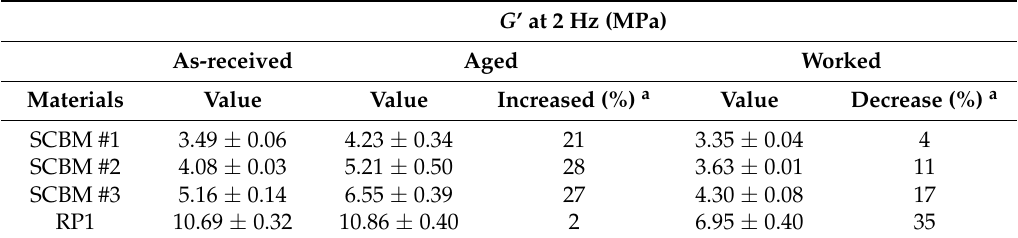
Figure 6. Dynamic shear storage modulus ( G ’) as a function of frequency measured at 25 °C for the as-received (solid circle • ) and worked (open triangles (cid:52) ) materials. The lines are guides for the eye. The error bars represent standard deviations of the mean from three separate measurements on different samples. View in color for best clarity. Table 2. The shear storage modulus ( G ’ ) at 2 Hz for as-received, aged, and worked SCBMs and RP1 from frequency sweep experiments at 25 °C.